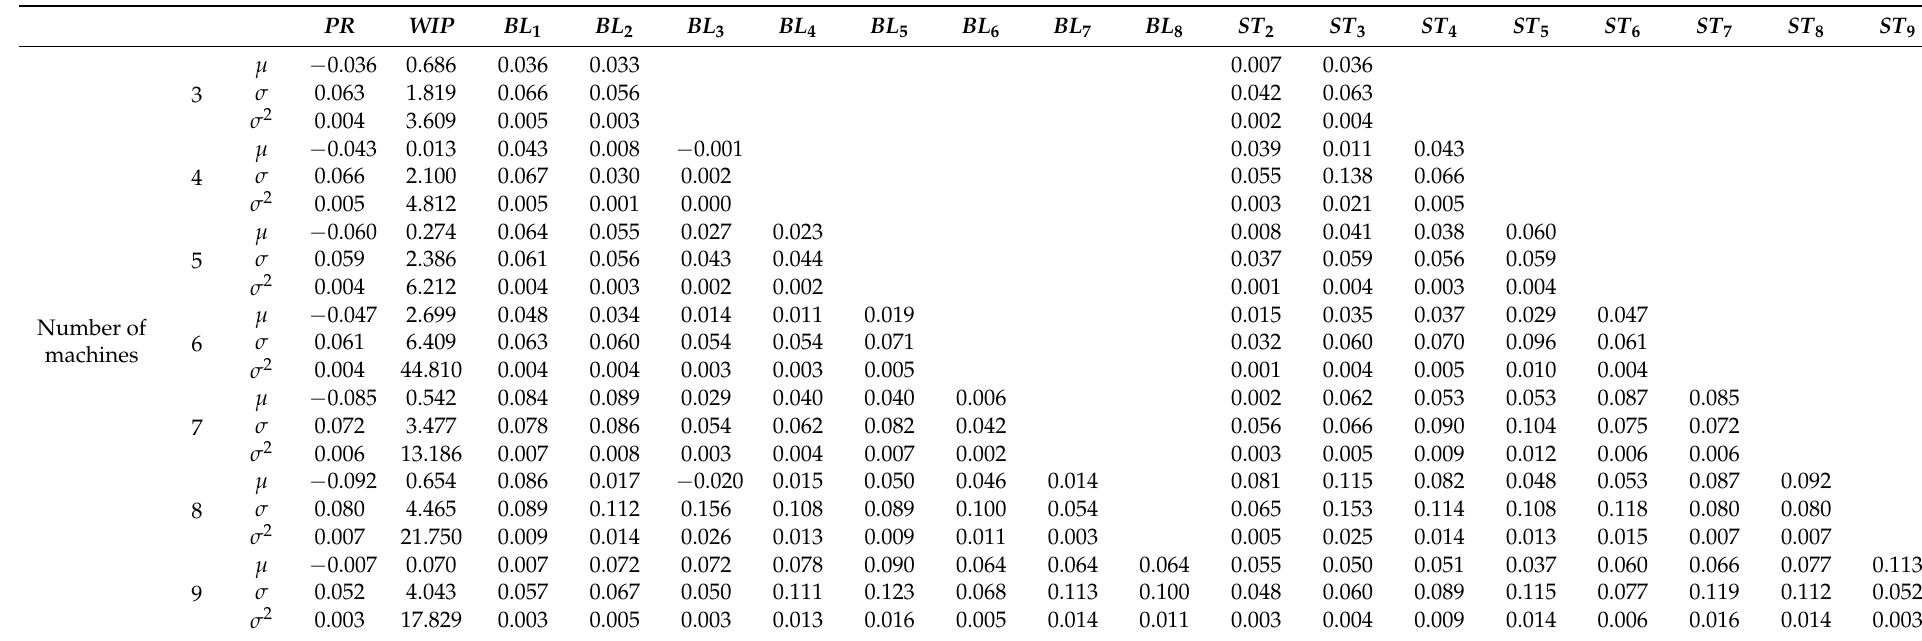
Table 3. Numerical method: mean value, standard deviation, and variance of the relative error concerning the analytical